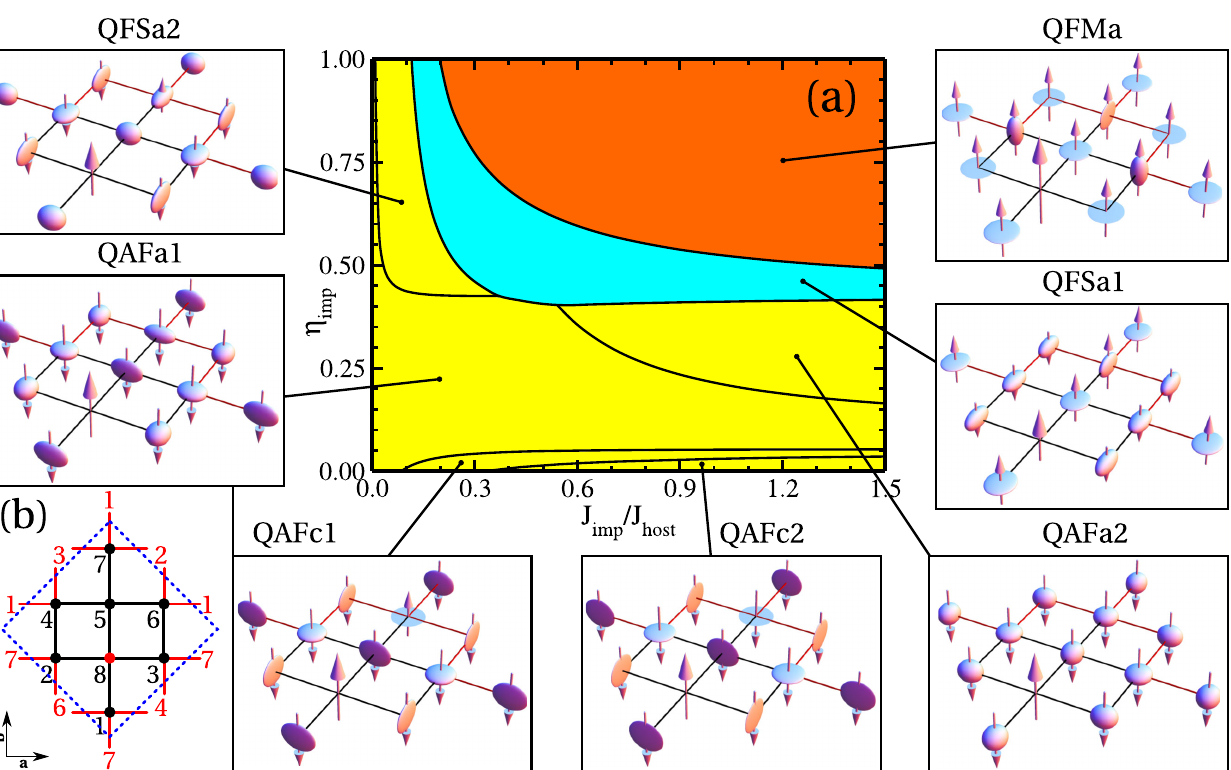
FIG. 13. (a) Phase diagram for the quantum problem at zero spin orbit simulated on the eight-site cluster in the presence of one impurity. Arrows and ellipsoids indicate the spin-orbital state at a given site i , while the shapes of ellipsoids reflect the orbital averages: a b c , h b † , and h c † (i.e., a circle in the plane perpendicular to the axis γ implies 100% occupation of the orbital γ ). (b) The periodic h a † i i i i i i i i i cluster of L ¼ 8 sites used, with the orbital dilution ( 3 d 3 impurity), at site i ¼ 8 . The dotted lines identify the basic unit cell adopted for the simulation with the same symmetries of the square